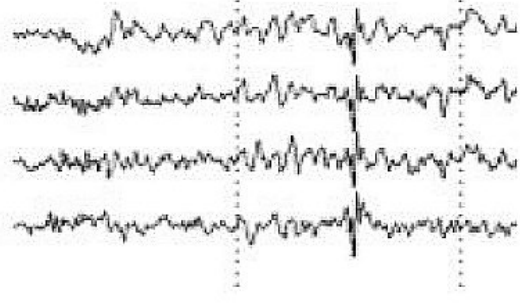
Figure 5. EEG data after eye blink